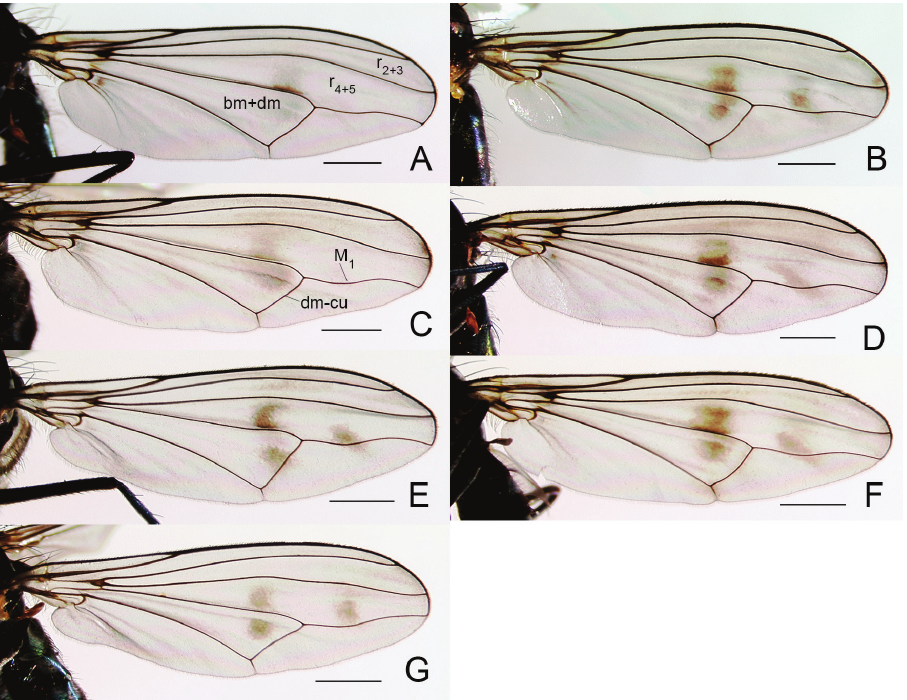
Figure 16. Wings of female species of Liancalus , A L. pterodactyl sp. n. B L. genualis Loew C L. hy- drophilus Aldrich D L. limbatus Van Duzee E L. similis Aldrich F L. sonorus sp. n. G L. querulus Osten Sacken. Wing cells bm+dm, r and r are labeled in ( A ); wing veins dm-cu and M 2+3 4+5